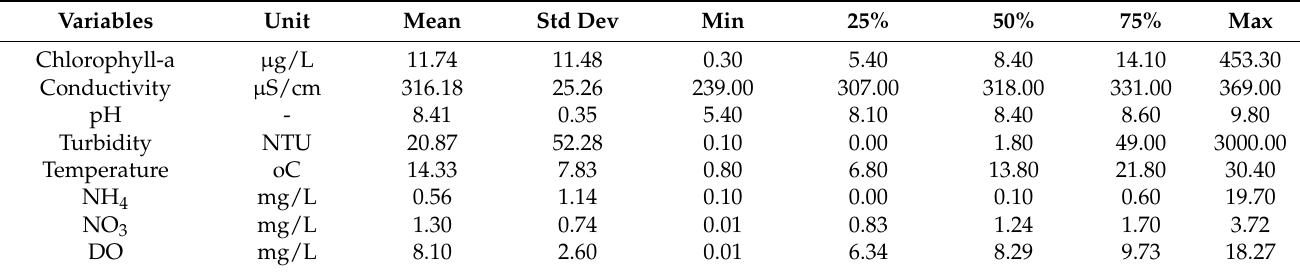
Table 2. Descriptive statistics of the water quality data for Toichio